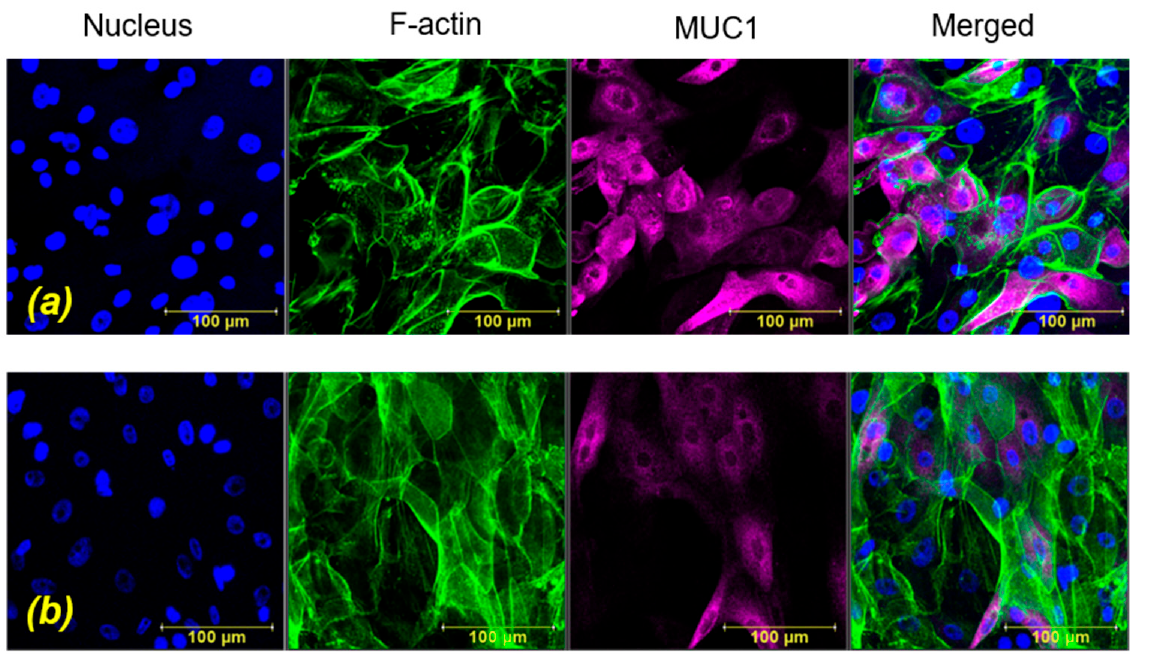
Figure 2. Representative projection images of human conjunctival epithelial cell (HCEC) in vitro